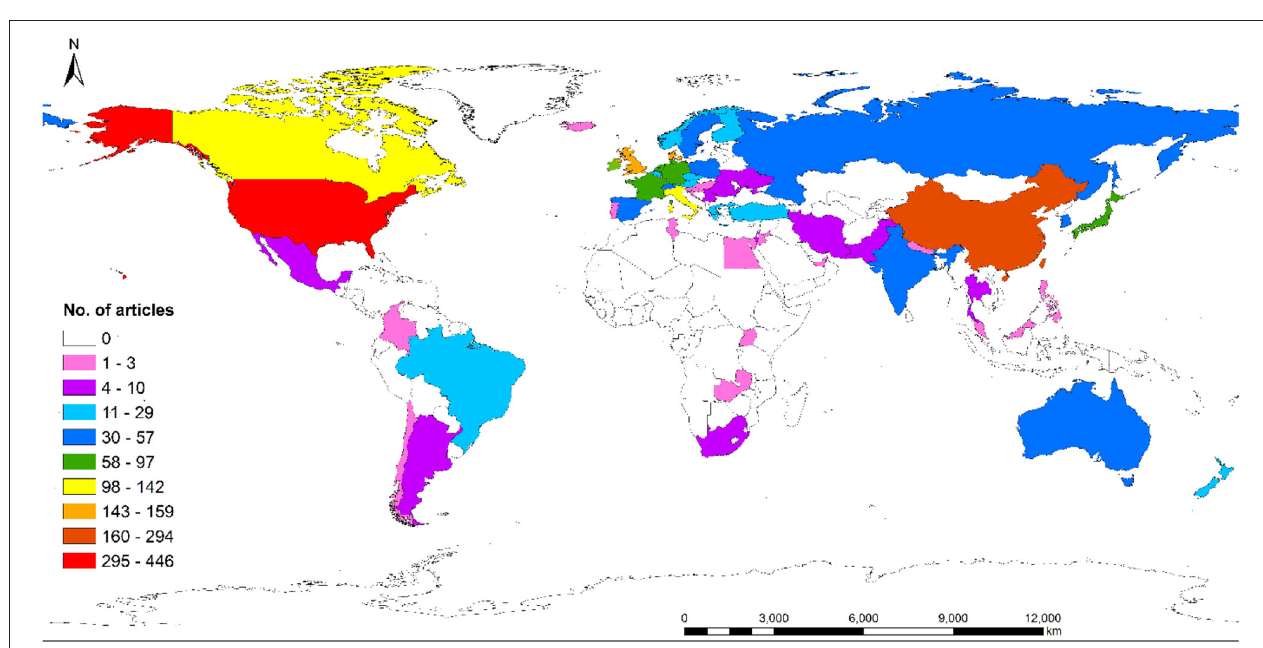
FIGURE 3 | Global distribution of ERAS